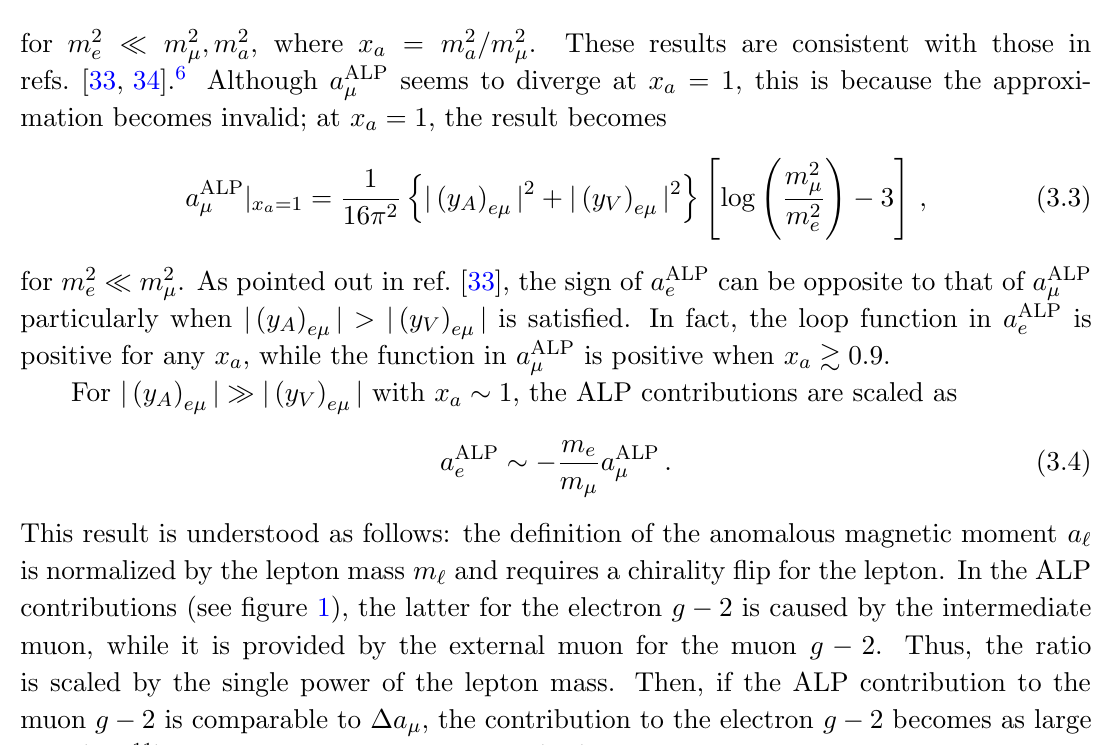
Figure 2 . (cid:1) a e and (cid:1) a (cid:22) are explained in the green and yellow regions within the 2 (cid:27) level, respec- tively, for m a = 110 MeV (left), m a = 1 : 5 GeV (middle) and m a = 10 GeV (right). The blue-shaded regions are excluded by the muonium-antimuonium oscillation bound at the 90%